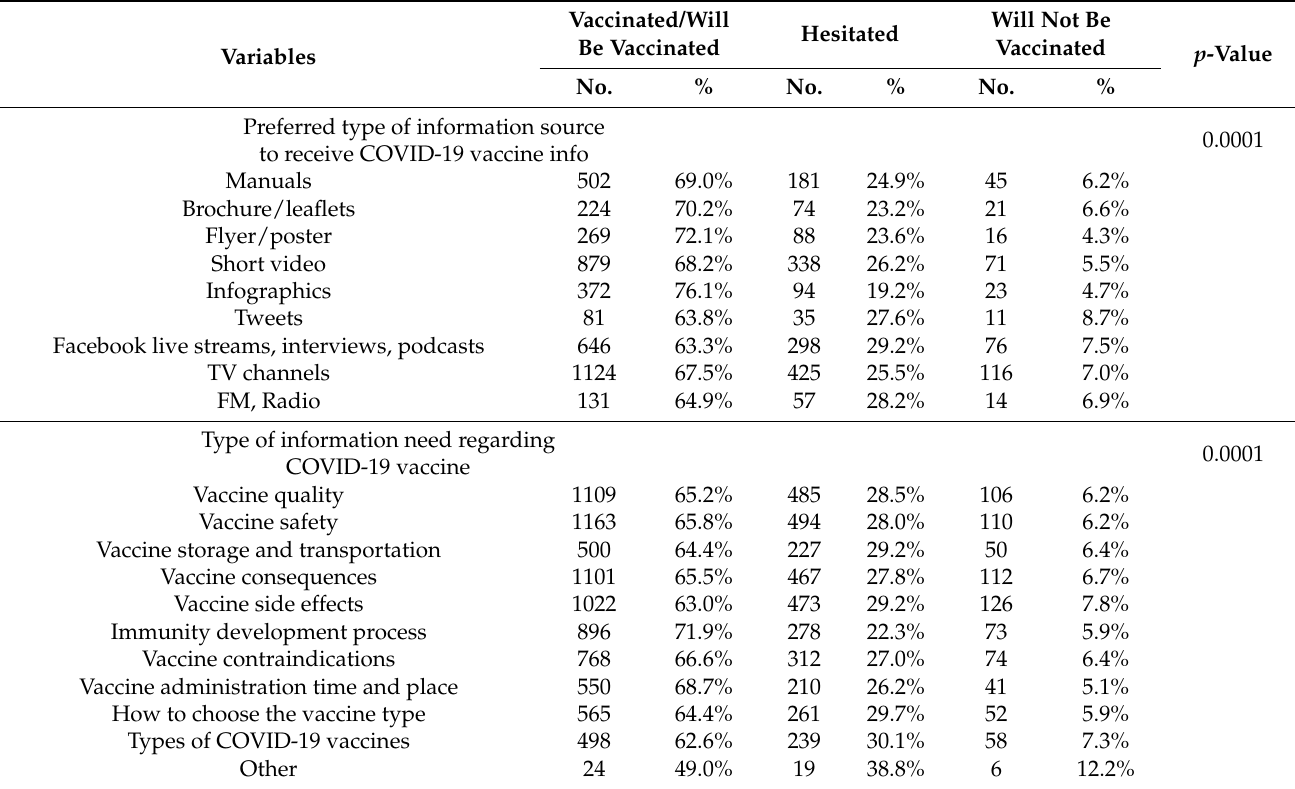
Table 6. The various information sources compared to the respondents’ willingness to be vaccinated for COVID-19, and the type of information needed regarding COVID-19.